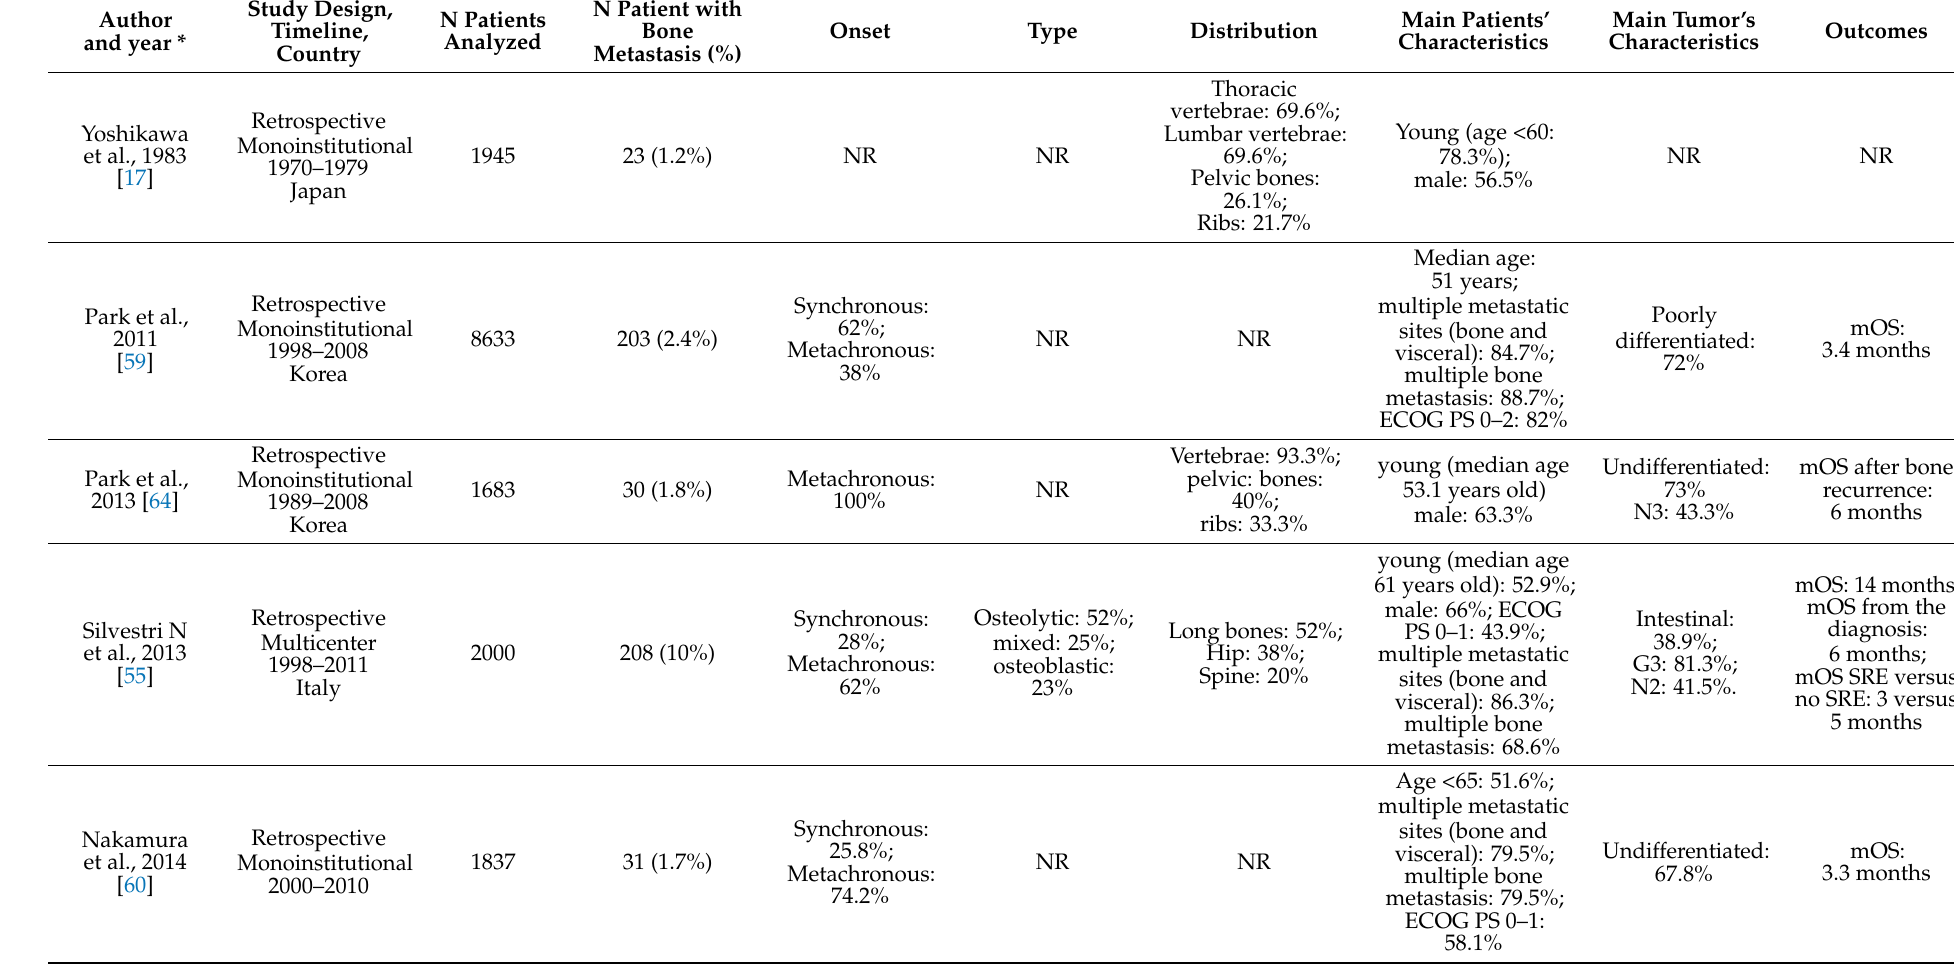
Table 1. Clinical overview about bone metastases characteristics in gastric cancer